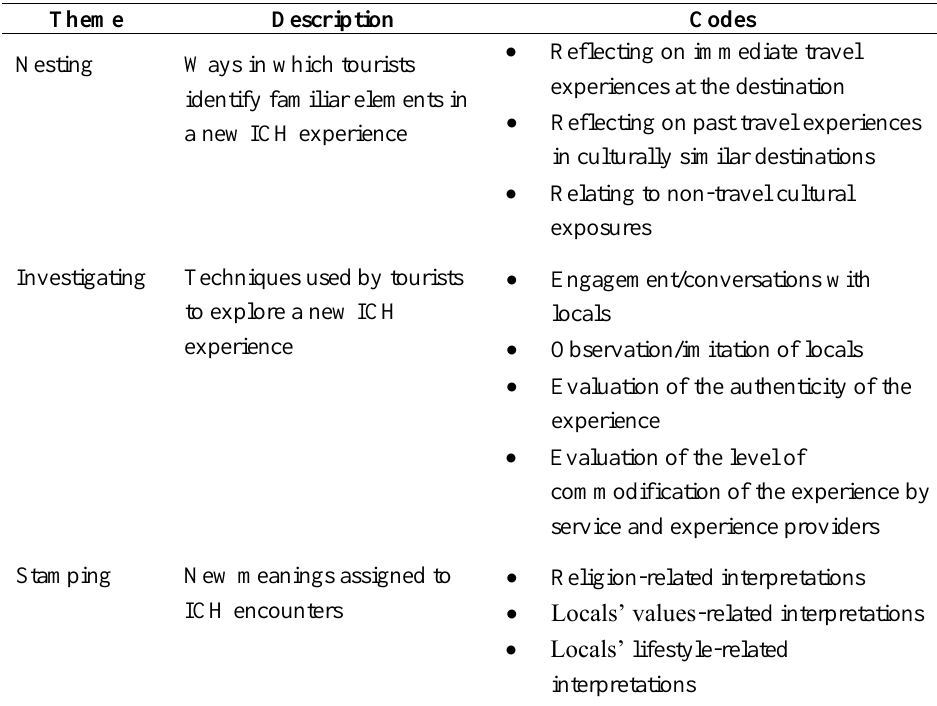
Table 2: Theme Descriptions and Codes